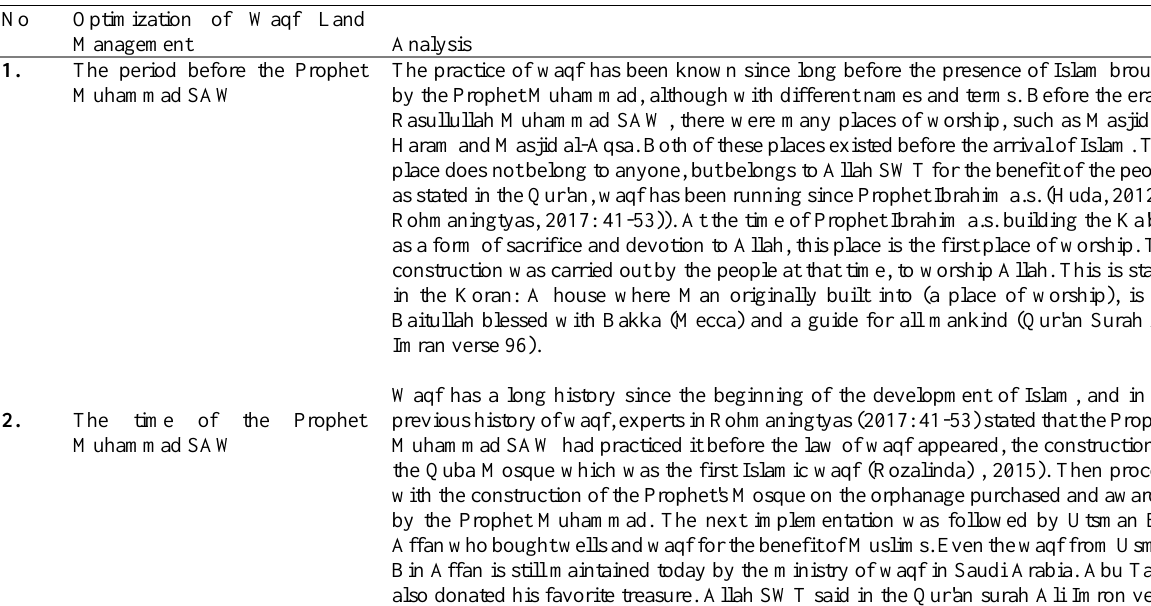
Table 3: Optimization of Waqf Land